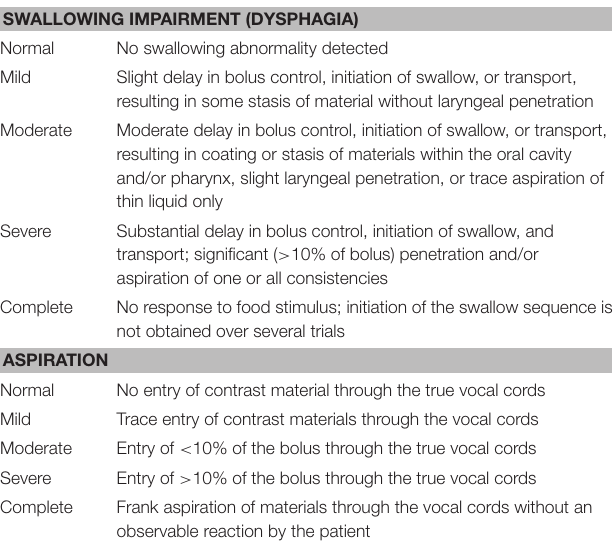
TABLE 3 | Videofluoroscopic diagnostic criteria for dysphagia and aspiration, adopted from Mann et al. (16). SWALLOWING IMPAIRMENT